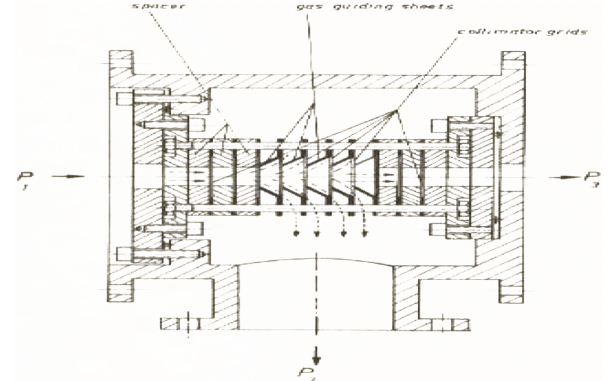
Figure 32. Soller collimator with differential pumping (reproduced from Schmidtke, 1971; copyright 2015, AIP Publishing LLC) de- signed for transmitting EUV radiation from open EUV sources at 5mbar to spectrometers at 10 − 5 mbar.